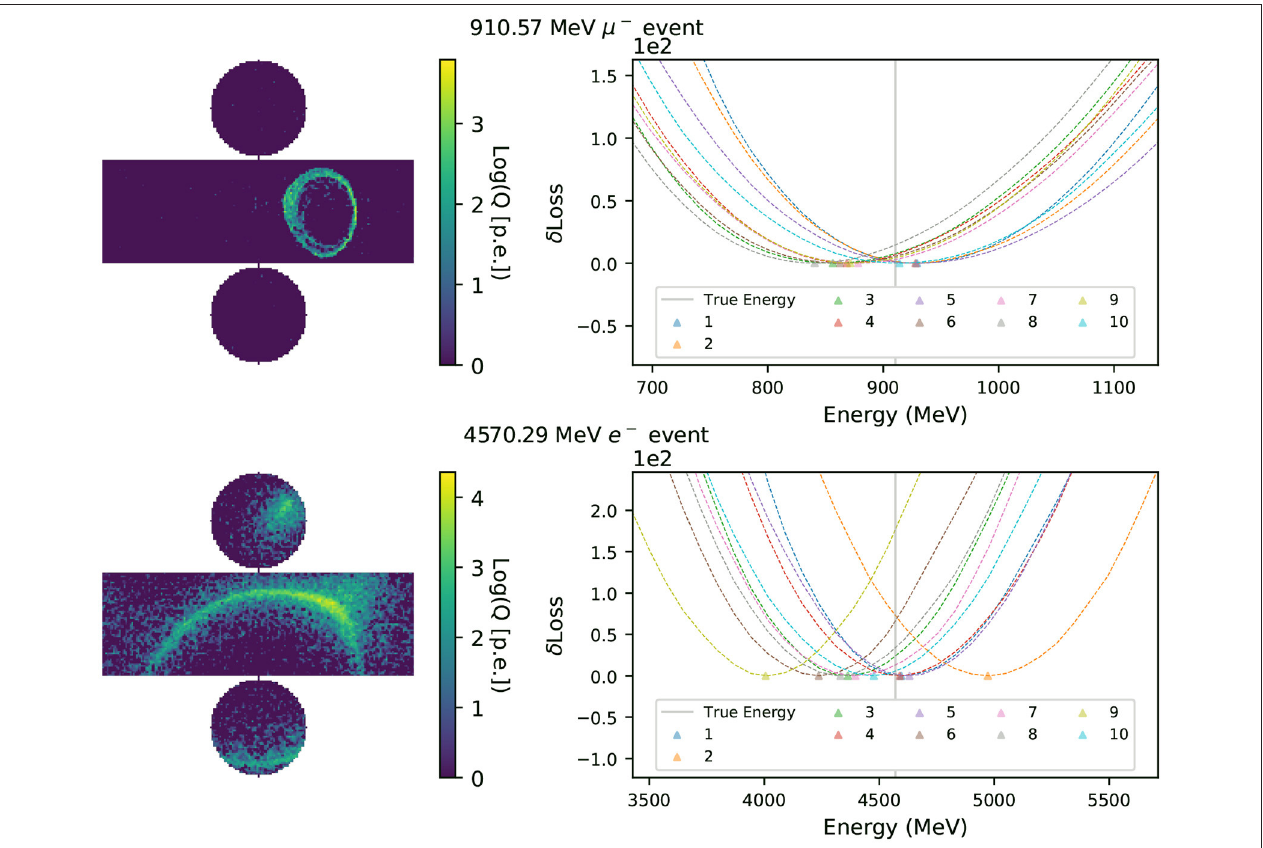
FIGURE 7 | Energy scans of a muon (electron) event are shown in the top (bottom) row. The left column shows the simulated hit charges in each event in logarithmic scale, with the cylindrical detector’s surface unrolled in two dimensions. In the right column the y-axis shows δ Loss( q ) with the minimum in each curve subtracted. The energies that minimize the likelihood functions, E rec , of charge-only networks with 1 10 Gaussian components are marked with triangles. The event’s true energy is ∼ shown as a solid vertical line.